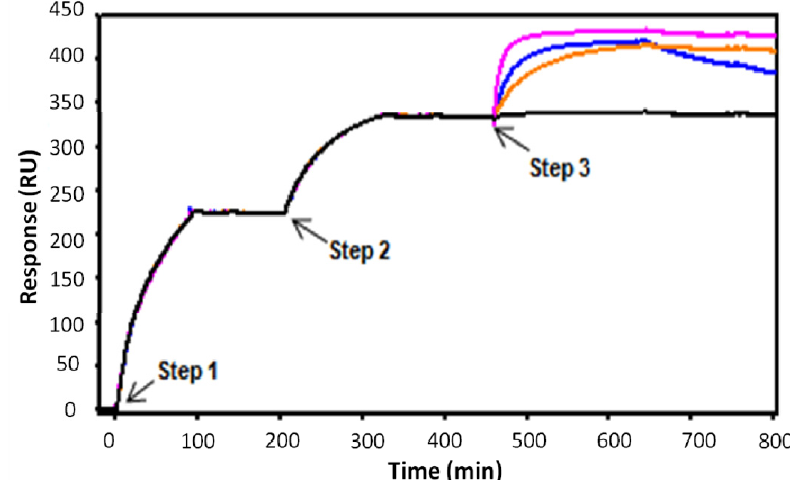
Figure 7. SPR sandwich assay for detection of ricin using 7G12 mAb for capture and rFabs as secondary detecting reagents. Four different assays (sensorgrams) are overlaid in the diagram. Step 1: Injection & capture 7G12 mAb onto a CM5 chip surface containing rabbit anti-mouse IgG, Fc specific polyclonal antibody; Step 2: Injection and binding of ricin (at 100 nM) to captured 7G12 mAb; Step 3: Injection & binding of rFabs to captured ricin (all at 50 nM)–chain-shuffled construct (magenta), 14F11 (blue), 9C3 (orange) and 8G2 rFab (black, negative control showing no binding to captured